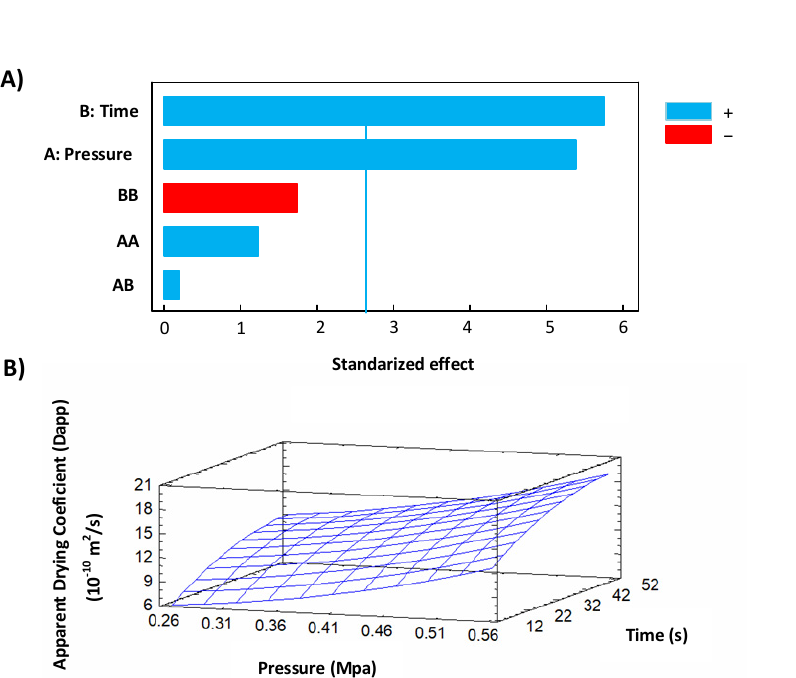
Figure 7. Effect of DIC treatment on effective diffusivity: ( A ) Pareto chart and ( B ) response surface graph.